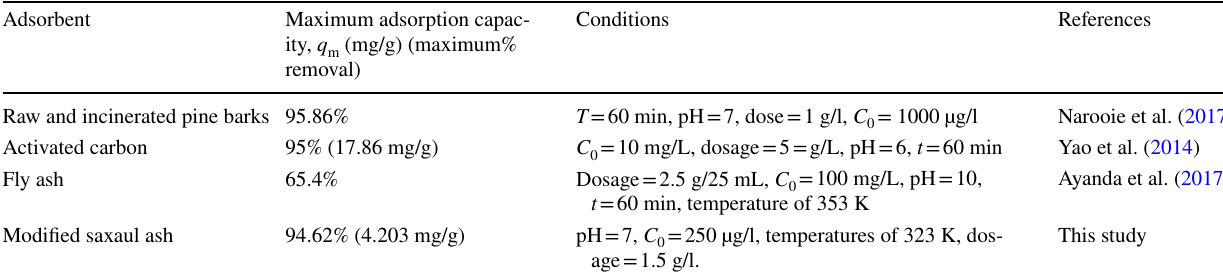
Table 3 Adsorption capacities of different adsorbents for arsenic removal Adsorbent